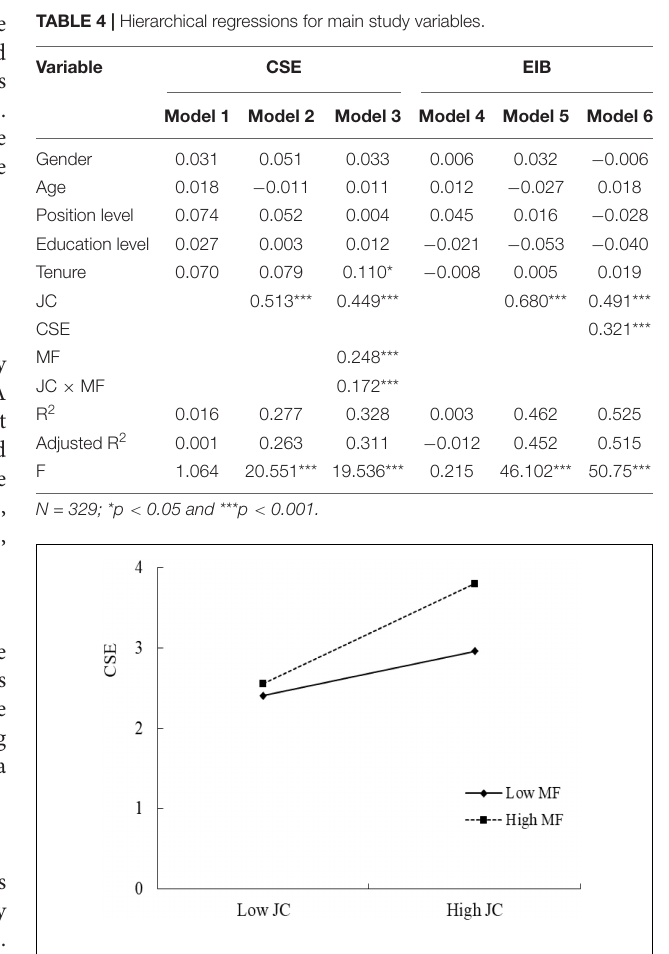
FIGURE 2 | The moderating effect of mindfulness (MF) on the influence of job control (JC) on creative self-efficacy (CSE).